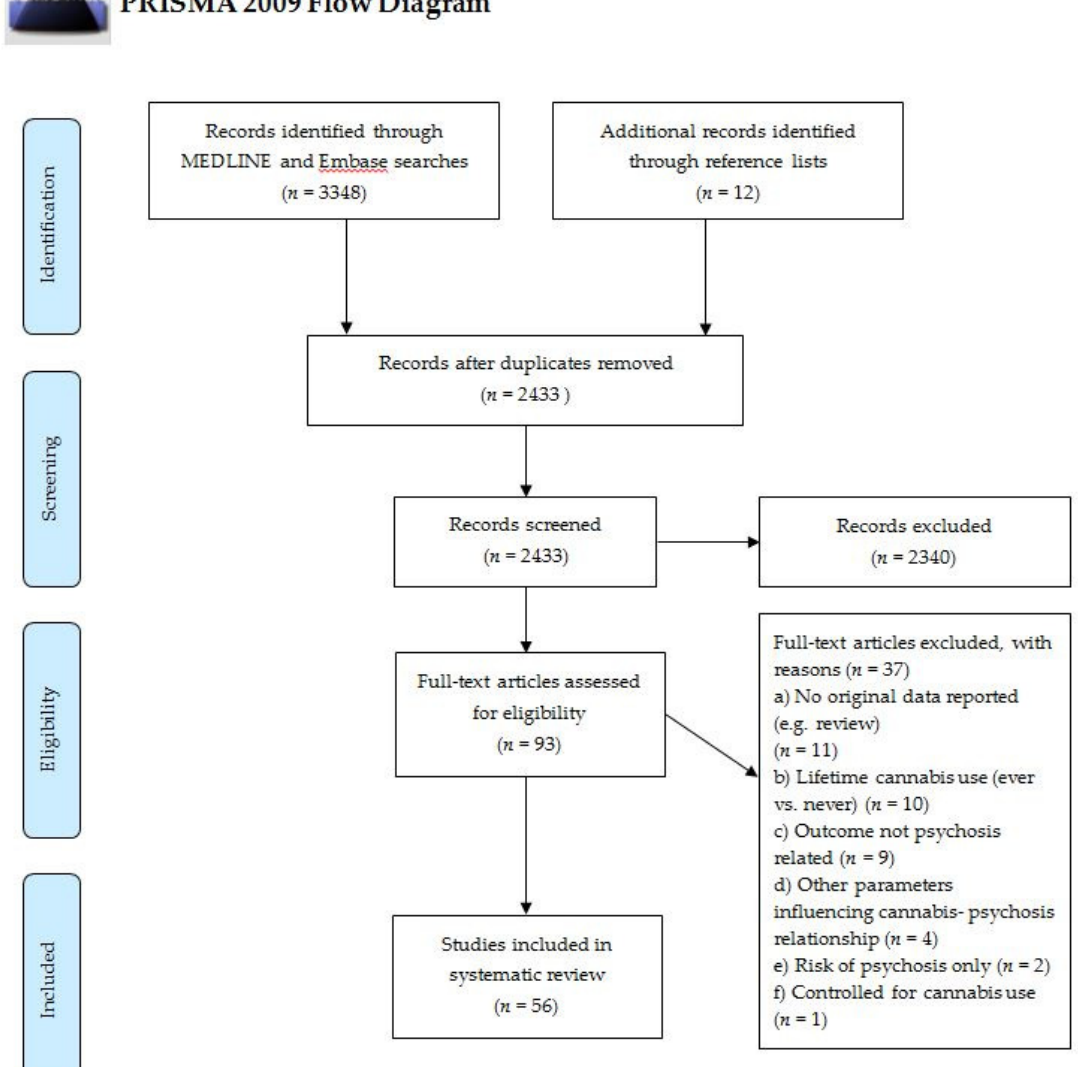
Figure 1. Literature search and selection of studies adapted from the Preferred Reporting Items for Systematic Reviews and Meta-Analyses (PRISMA) flowchart (http://www.prisma-statement.org/).